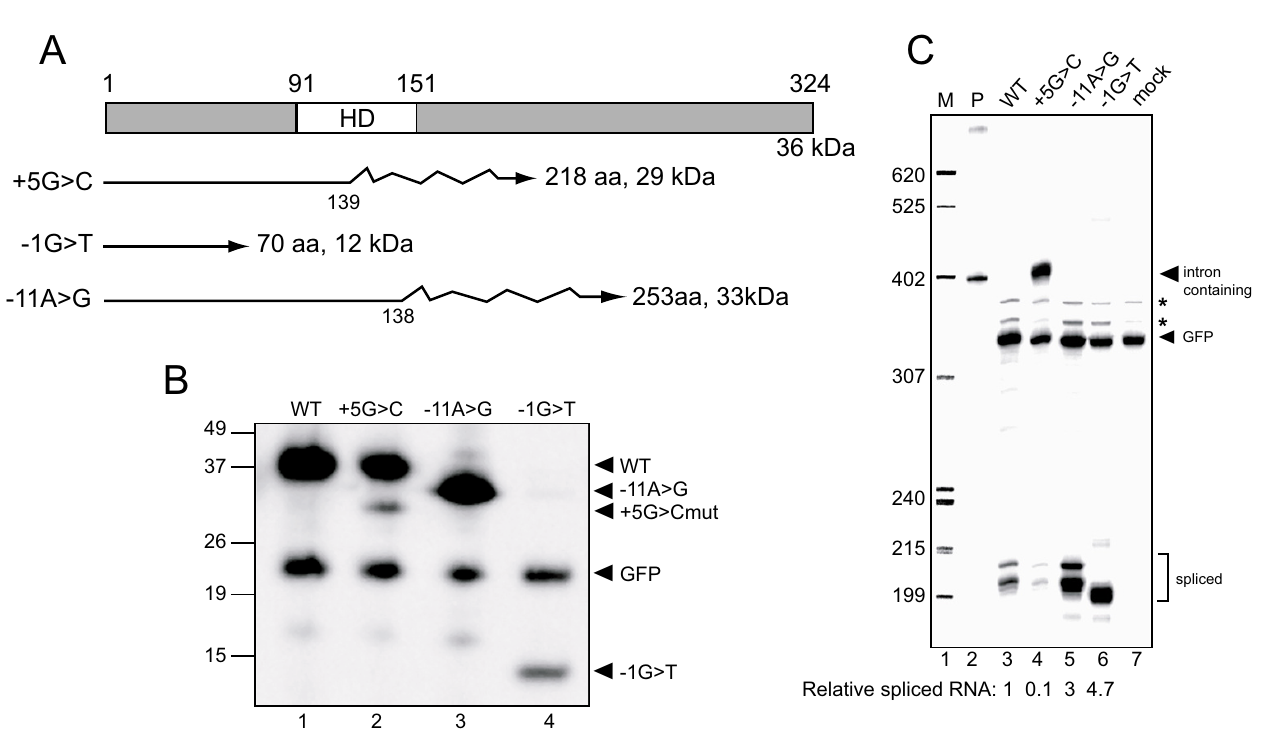
Figure 6 Analysis of protein expression from mutant minigenes . A. The domain structure of PITX2c protein with the position of the homeodomain (HD) is shown. Lines below represent the proteins that would result from aberrantly spliced RNA caused by each of the mutations. Straight lines indicate normal protein and jagged lines indicate incorrect amino acids gener- ated by frame shifts; the number of normal amino acids and full-length size is shown for each. B. Western blotting of indicated FLAG epitope-tagged PITX2c and GFP proteins expressed in HEK293 cells. WT, protein from a wild type minigene transfec- tion; +5G>C, protein from IVS4+5G>C mutant minigene transfected cells; -11A>G, protein from IVS5-11A>G mutant mini- gene transfection; -1G>T, protein from IVS5-11A>G mutant minigene transfected cells. The positions of wild type, +5G>C,